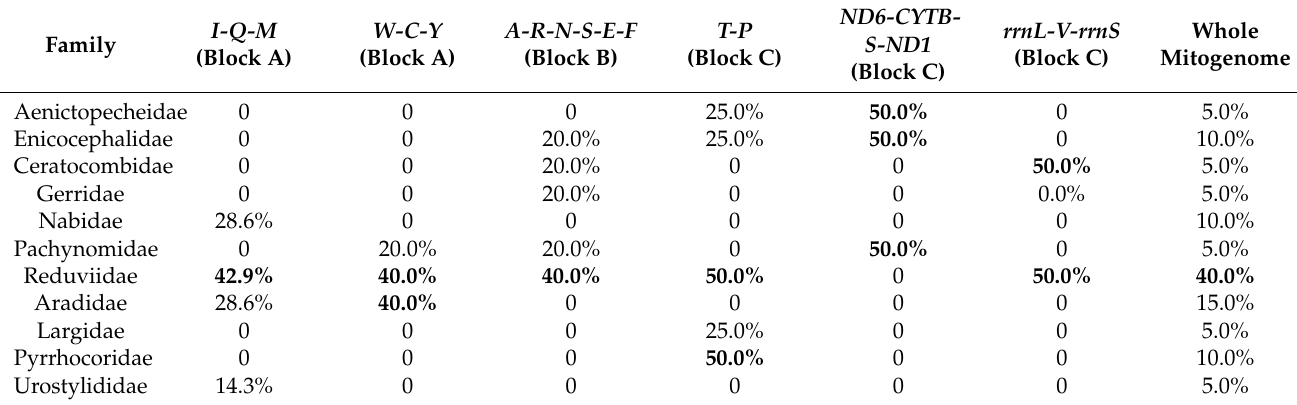
Table 2. Gene rearrangement richness of rearrangement units and whole mitogenome for heteropteran